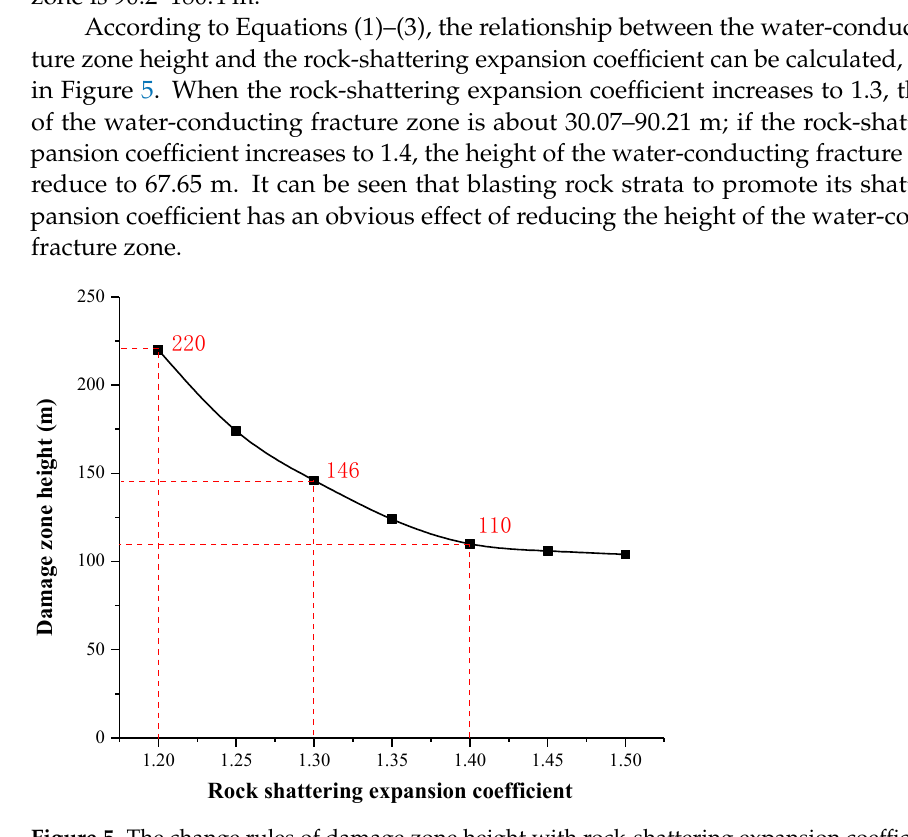
Figure 5. The change rules of damage zone height with rock-shattering expansion coefficient.